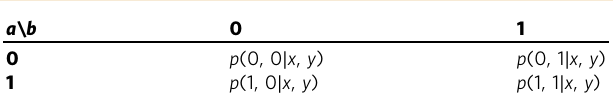
Table 1 The correlation table on question ( x , y ) of a correlation on answer sets A ¼ B ¼ f 0 ; 1 g